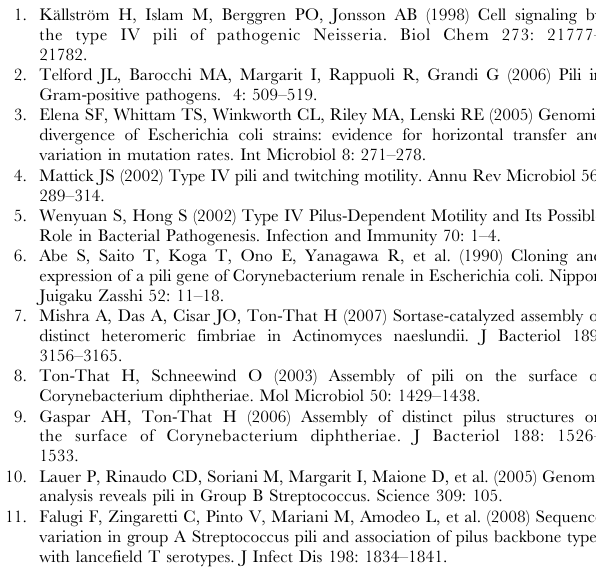
Figure S3 Fitting of the RrgBD1 computer model into the 3D map of the S. pneumoniae pilus. A) Computer model of the D1 domain and sequence alignment of RrgB D1 to the N-terminal domain of Spy0128 (PDB code 3B2M). Gold rectangles depict the localization of beta strands on the crystal structure. B) The overall protein fold is represented as a ribbon; the side-chains of Lys41 and Asn184, involved in the intra-molecular isopeptide bond are highlighted. Lys162, with putative involvement in the inter- molecular isopeptide bond is evidenced in grey. B) After fitting, D1 and D2-D4 coordinates were merged into a single file and overlapping atoms were removed. The resulting RrgBD1-D4 model was visually inspected for absence of steric conflicts and minimized with the same protocol used for D1. Threading was performed with SwissPDBViewer, surface representation and molecule rendered with Chimera. Crystal structures are in cartoon representation and the three domains are coloured following the nomenclature of Figure 3. Figure produced with Pymol (http:// www.pymol.org/). Surface representation and molecule rendered with Chimera.